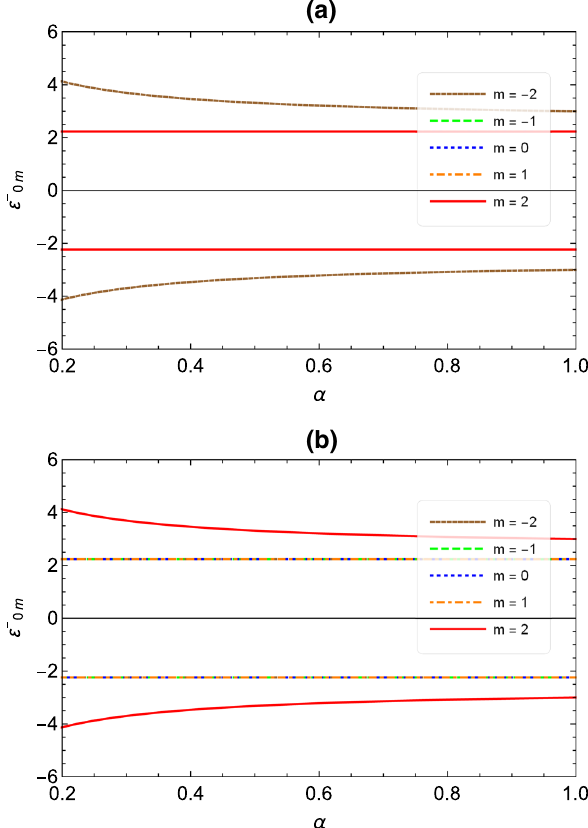
Fig. 8 The energy (cid:20) − as a function of the parameter α . In a the plot 0 m for s = 1 and b for s = − 1. We use M = 1. The only non-degenerate states affected by curvature are those with m (cid:3) − 2 in a and m (cid:2) 2 in b . All states with m < 2 are not affected by curvature